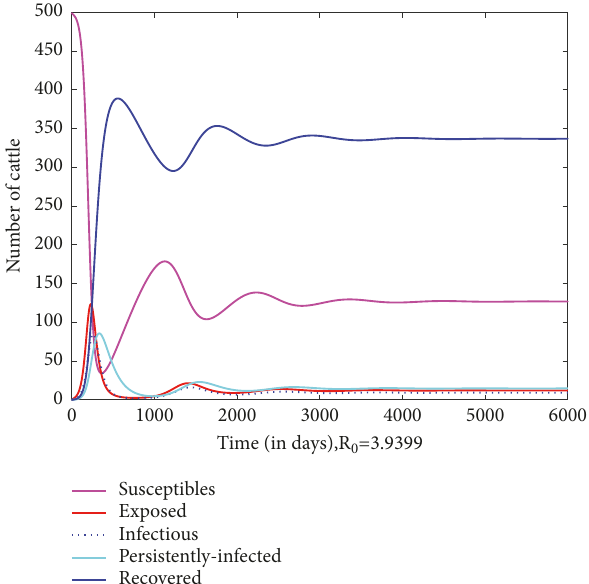
Figure 3: Number of cattle in each compartment for parameter values in Table 1 with 𝛼 𝑟 = 1/56 (as in [10]) and 𝐼 0 = 1, 𝑆 0 = 499,𝐸 = 𝑄 = 𝑅 = 0 , giving approximate equilibrium values 0 0 0 𝑆 ∗ = 127, 𝐸 ∗ = 12,𝐼 ∗ = 9, 𝑄 ∗ = 15, 𝑅 ∗ = 337 , and R